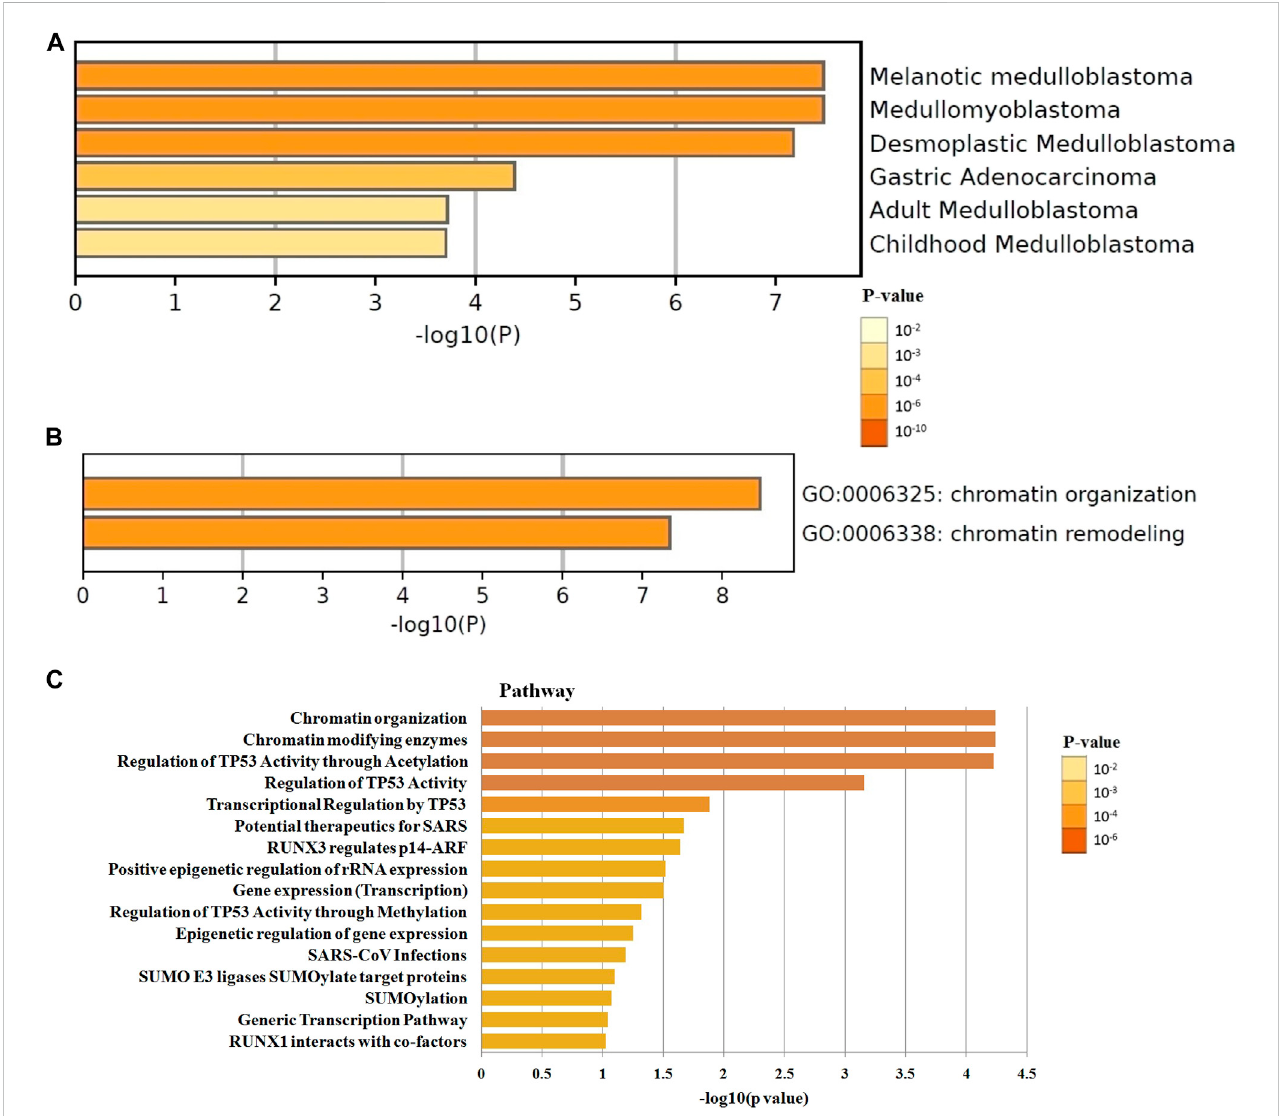
FIGURE 1 TheenrichmentanalysisofBETgeneswerepredictedbybioinformatics analysis. (A) Thetopfewenrichedclusterswereidenti fi edinDisGeNETontology categories in Metascape database. (B) The Go enrichment heatmap was plotted with p -value in Metascape database. (C) The Reactome pathway enrichment analysis of BET co-expression genes in David database. The more abundant the gene, the darker the